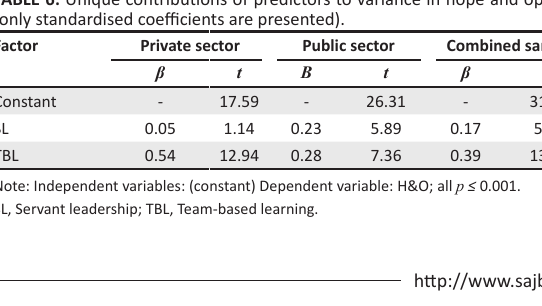
TABLE 6: Unique contributions of predictors to variance in hope and optimism (only standardised coefficients are presented). Factor Private sector Public sector